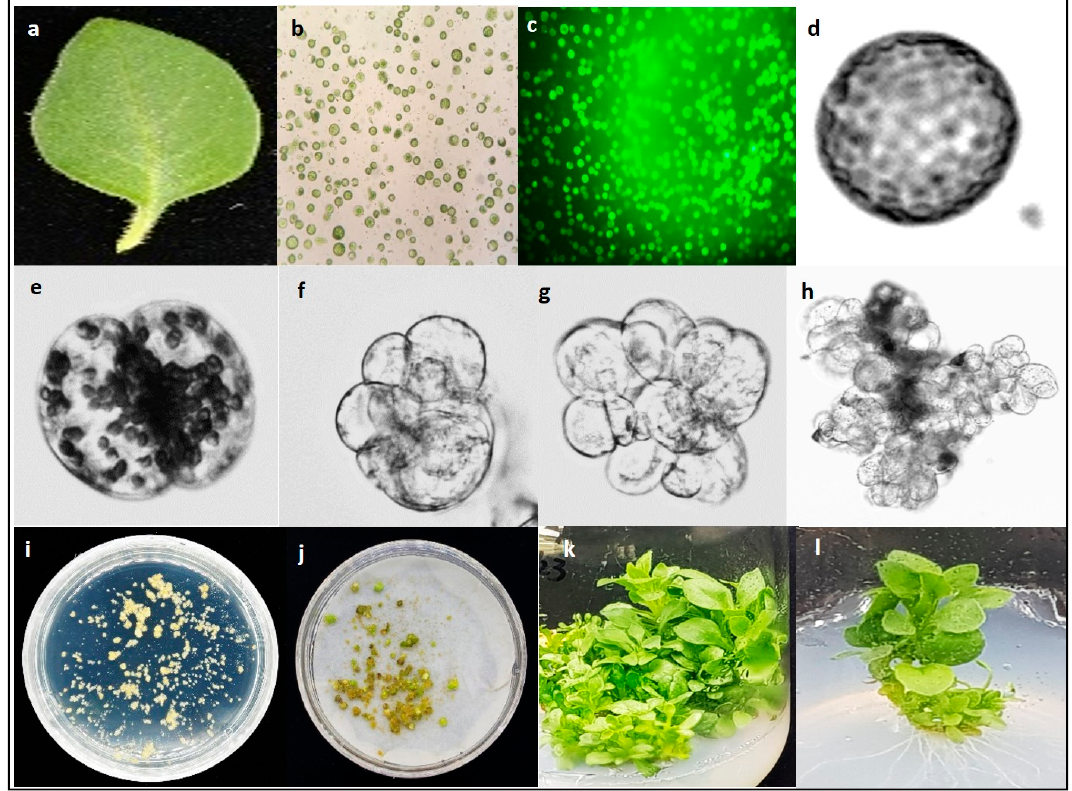
Figure 3. Protoplast isolation and shoot regeneration from a protoplast-derived callus of Petunia hybrida cv. Mirage Rose. ( a ) Fully expanded in vitro leaf used for protoplast isolation, ( b ) protoplasts isolated from leaf mesophyll cells, ( c ) protoplasts stained with fluorescein diacetate, ( d ) status of a single protoplast on day 1 in liquid culture, ( e ) first cell division on day 3, ( f ) second cell division on day 5, ( g ) third cell division on day 7, ( h ) microcolony formation, ( i ) microcalli formation from the microcolonies, ( j ) callus proliferation from microcalli, ( k ) shoot induction from the callus, and ( l ) in vitro rooted shoots derived from protoplasts.